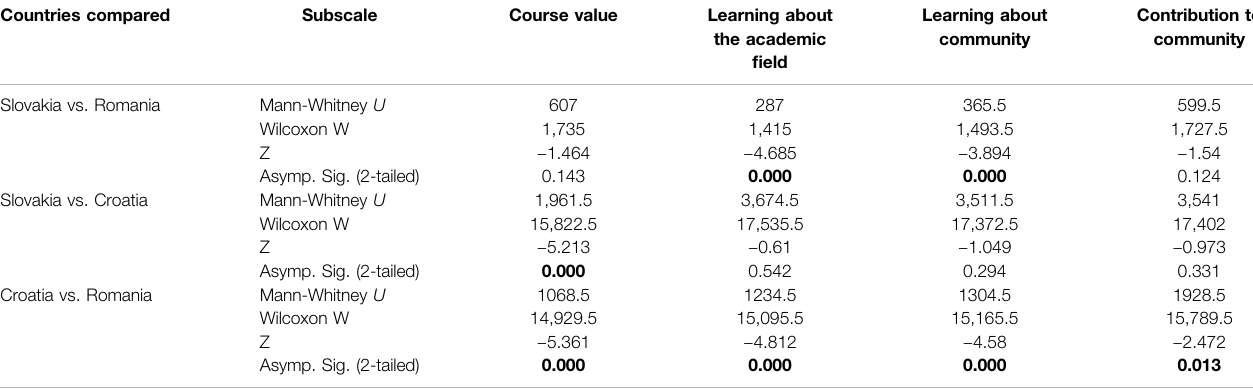
Note: The bold entries indicate the p values <